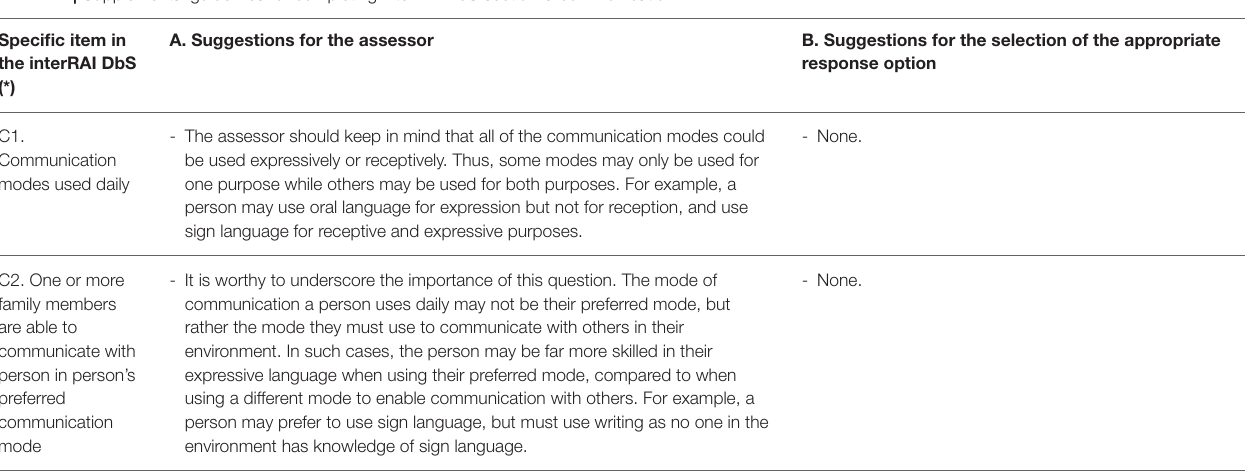
TABLE 4 | Supplemental guidelines for completing interRAI DbS section C